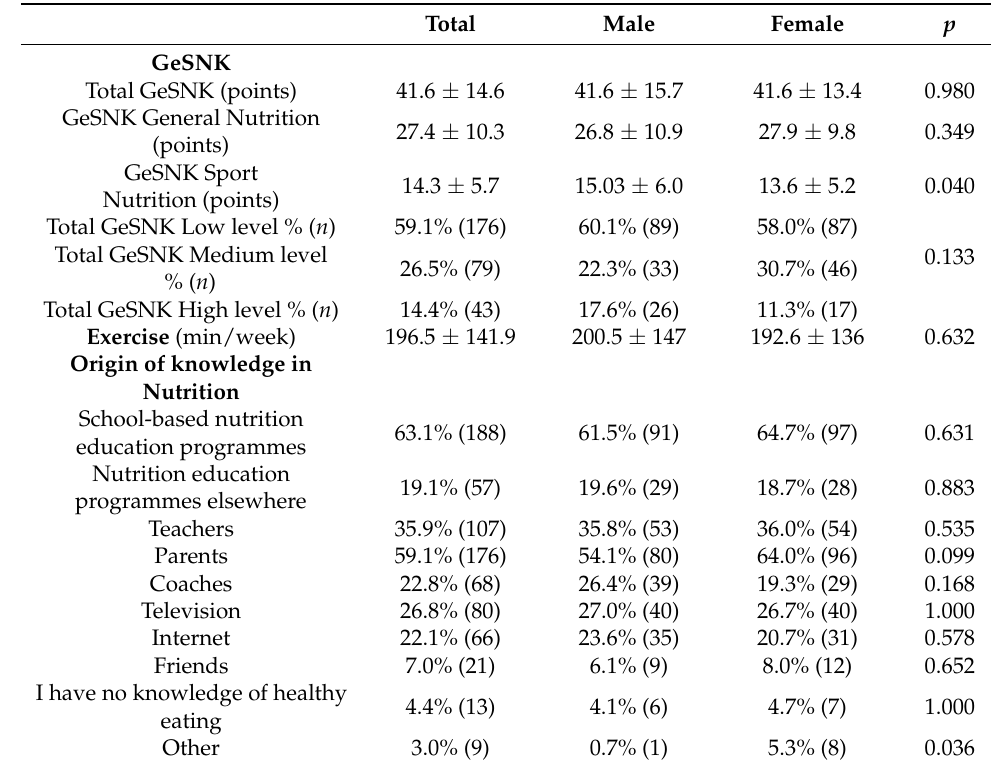
Table 3. GeSNK knowledge score in relation to